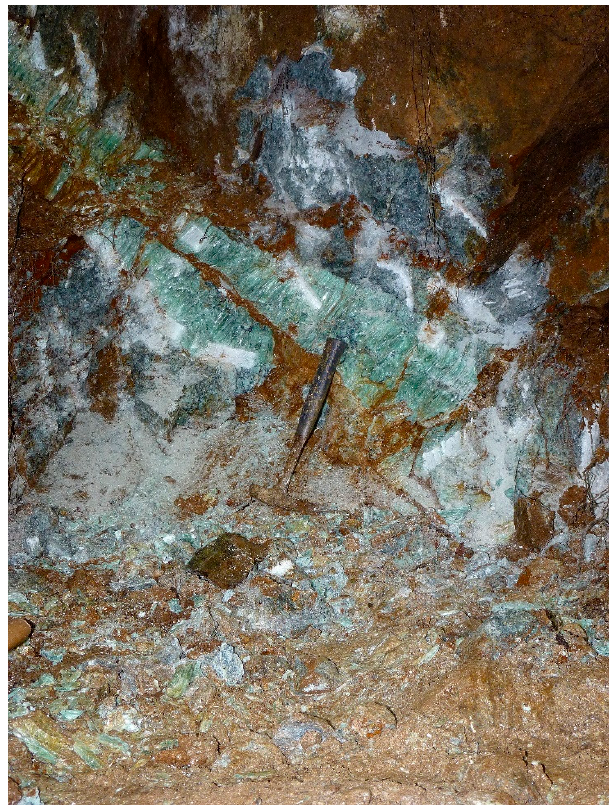
Figure 2. Vein of green talc in the serpentinite body at Muránska Dlhá Lúka deposit (Photo by T. Bancík).